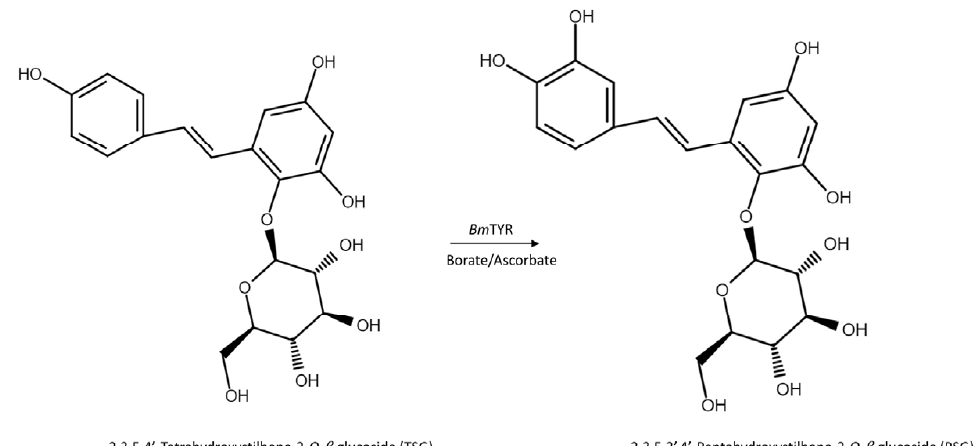
Figure 5. The biotransformation process of TSG by Bm TYR.